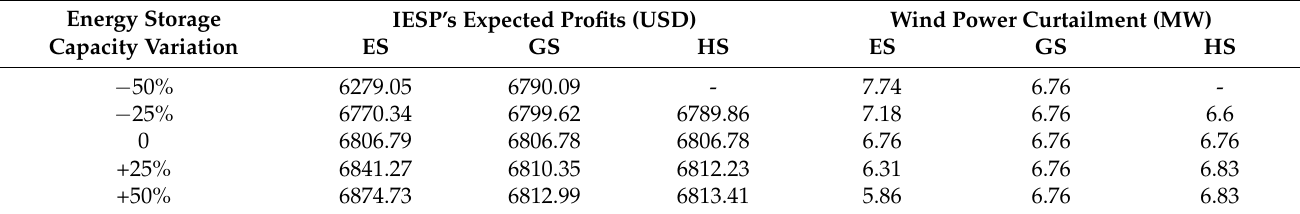
Table 4. Sensitivity analysis of energy storage capacity.